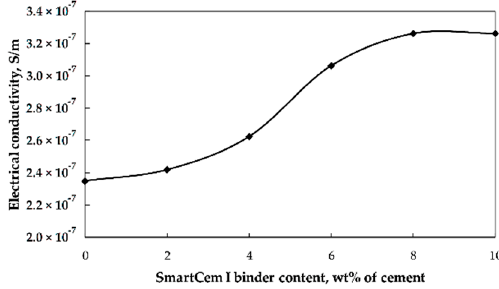
Figure 9. Effects of the SmartCem I content on electrical resistivity of 28 days old samples.